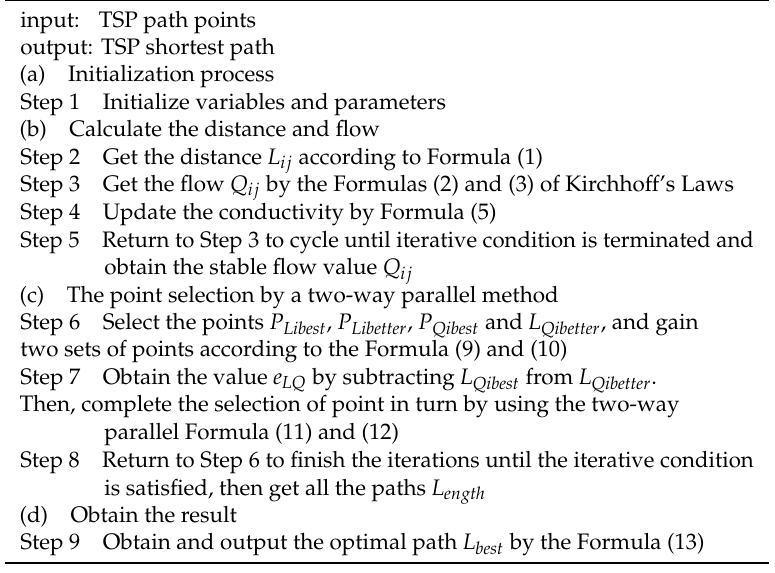
Table 1. The steps of